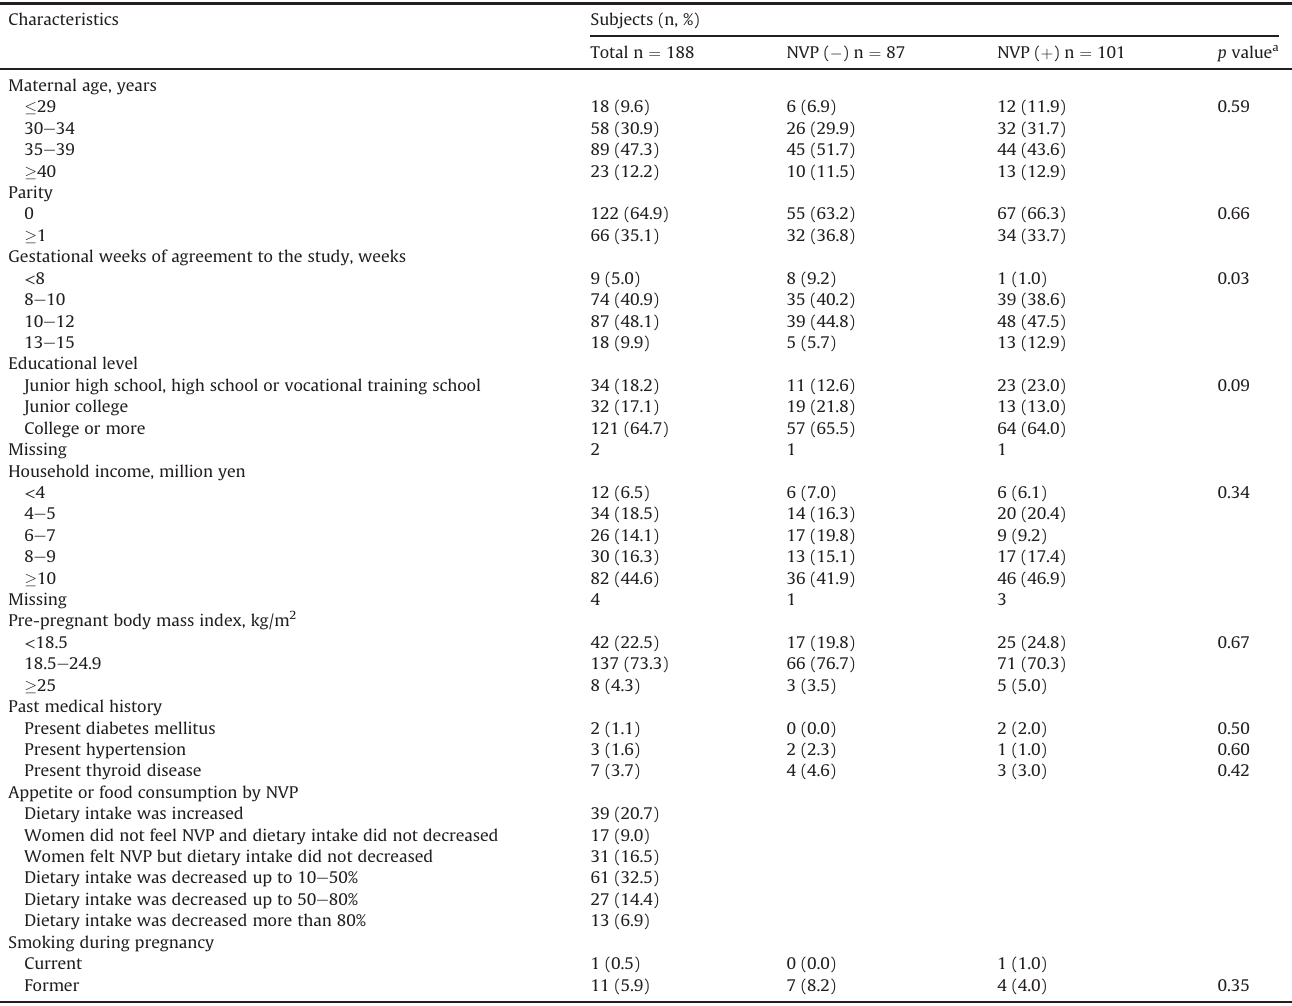
Table 1 Characteristics of participants (n ¼